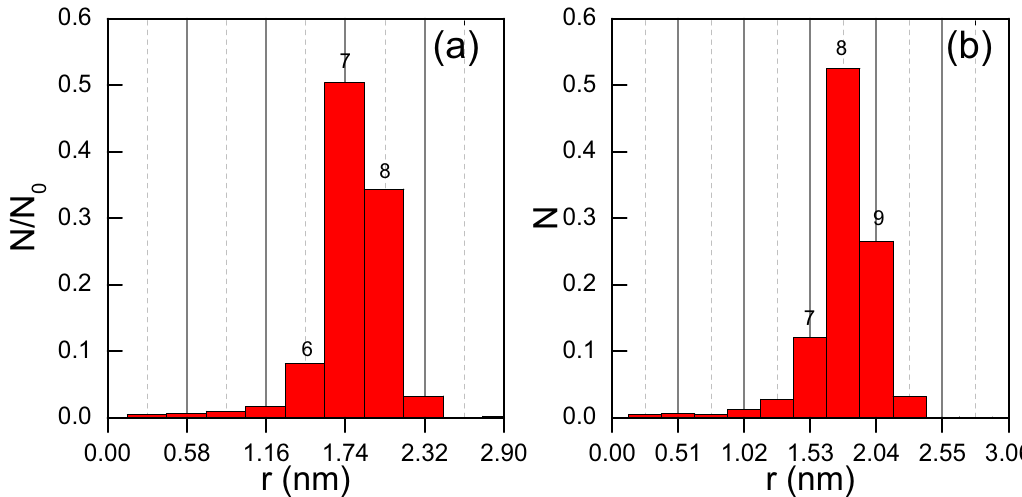
Figure 3. Statistics of rod length at different bin sizes, N 0 = 2229: ( a ) a Ag = 0.289 nm ( b ) a Cu = 0.255 nm; on top of bars corresponds to the number of atoms that form a rod of this